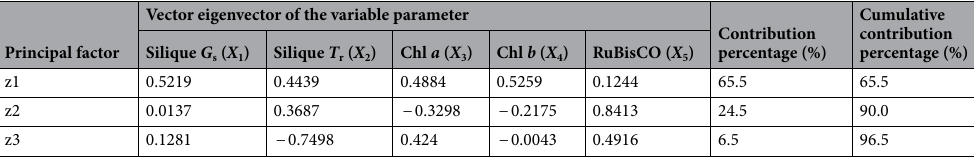
Table 6. The principal factors which affected rapeseed silique P n .